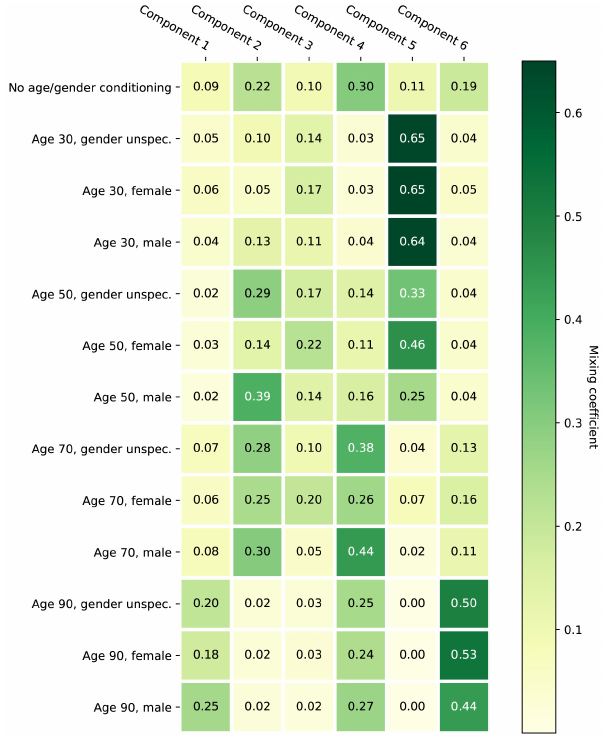
FIGURE 3 | A-priori mixing weights of the learned six-component model under various conditionings.